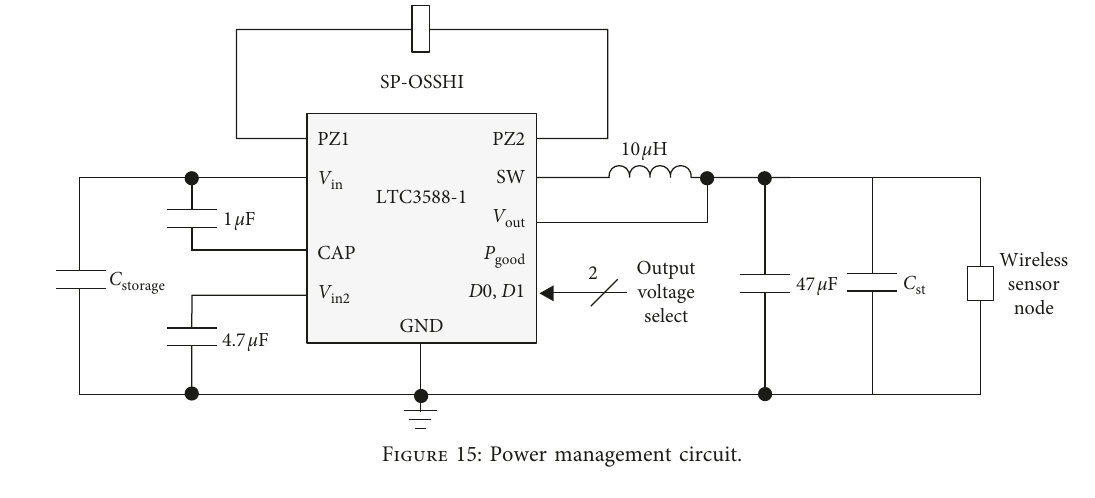
Figure 15: Power management circuit.